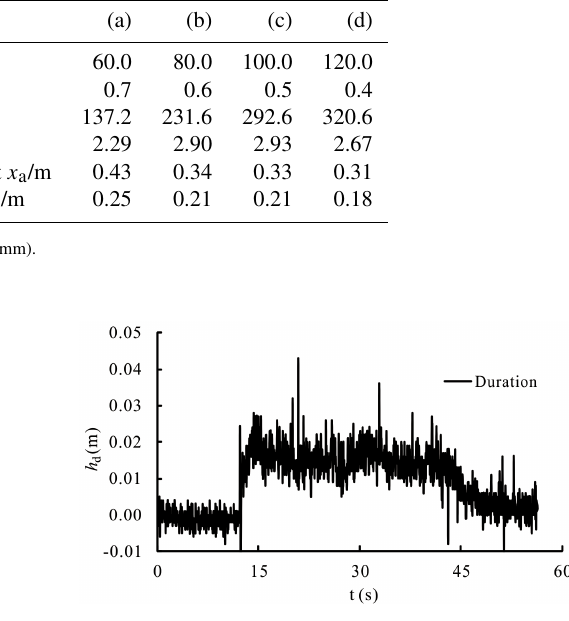
Figure 5. An example of a debris-flow